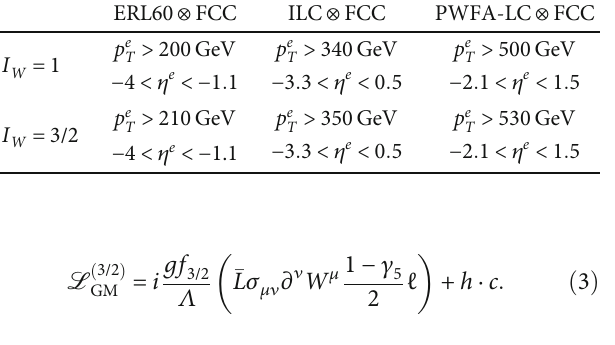
= 1 and Λ = M for various ep colliders. 3/2 L